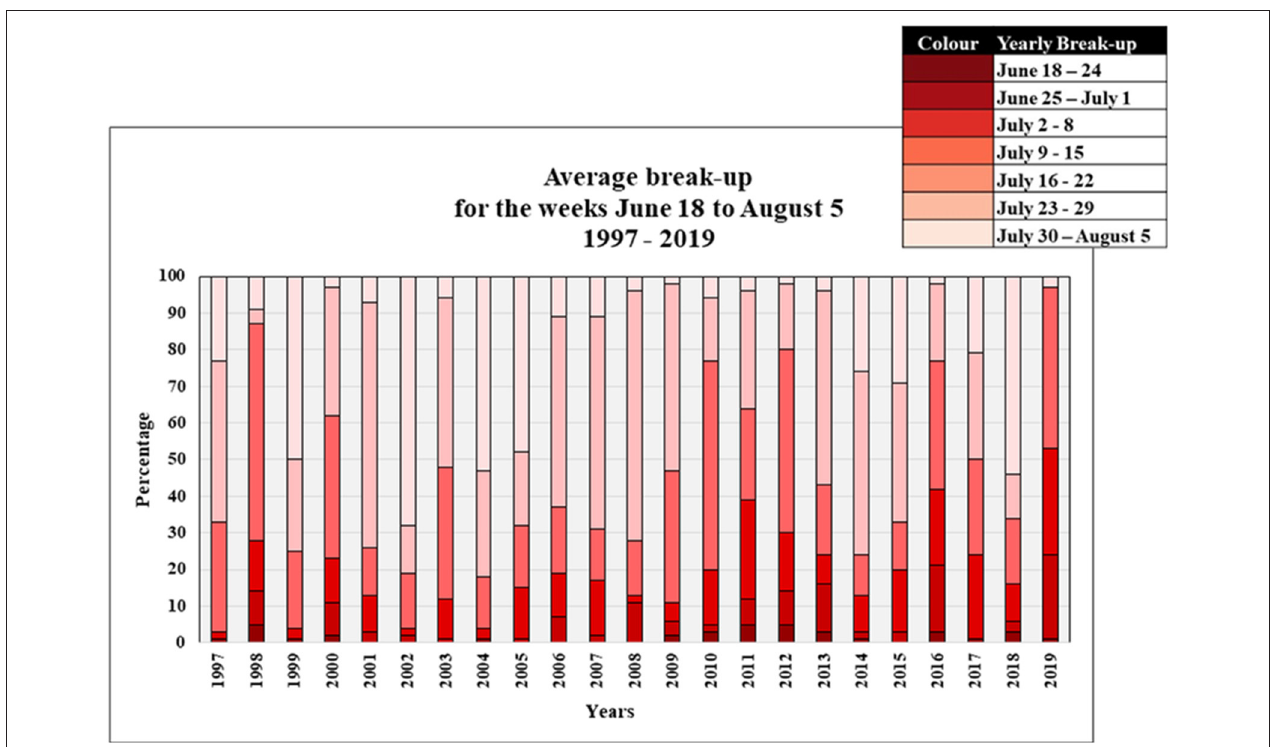
FIGURE 12 | Summary of average break-up between June 18 to Aug 5, 1997–2019. Each bar is a year showing the weekly percentage of break-up by color: dark red for late June; medium red for early July; and light red for the end of July. Years with darker red represent years that broke-up early. Years with more light red represent years that broke-up